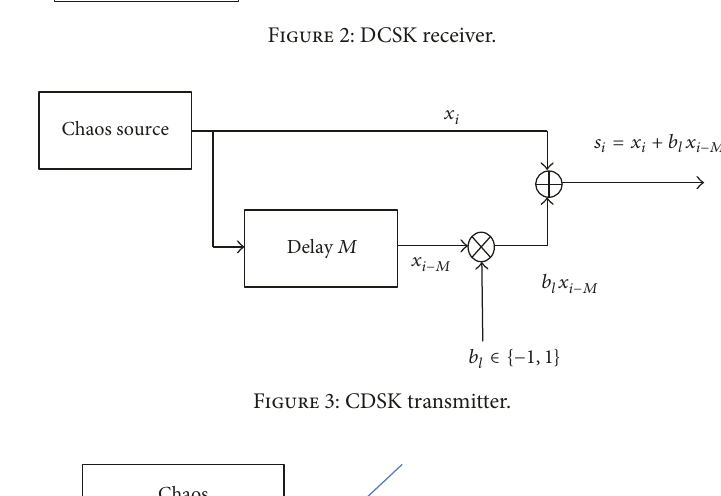
Figure 2: DCSK receiver.